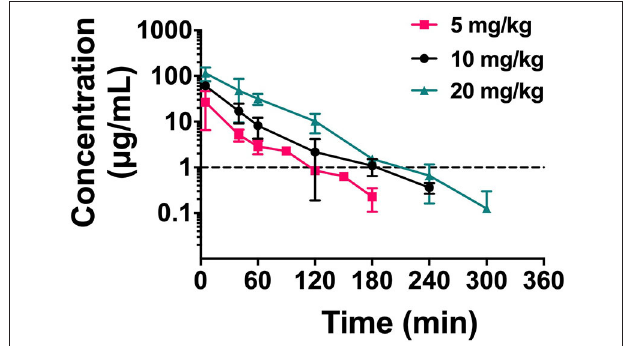
FIGURE 4 | The drug concentration-time curve of NZX. Free serum concentrations for NZX after single intravenous administration of NZX at escalating doses of 5-, 10-, and 20 mg/kg body weight in non-infected mice. Each symbol from five mice indicates the Mean ± SD. The dotted line represents the MIC value of NZX against S. aureus E48.